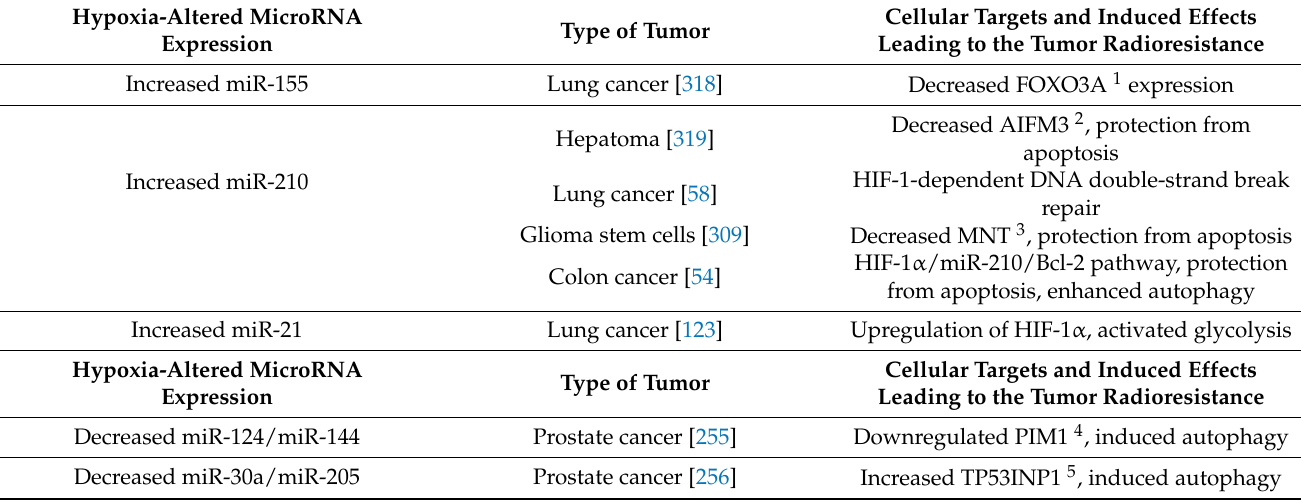
Table 3. Hypoxia-responsive microRNAs affecting the radioresistance of hypoxic tumor